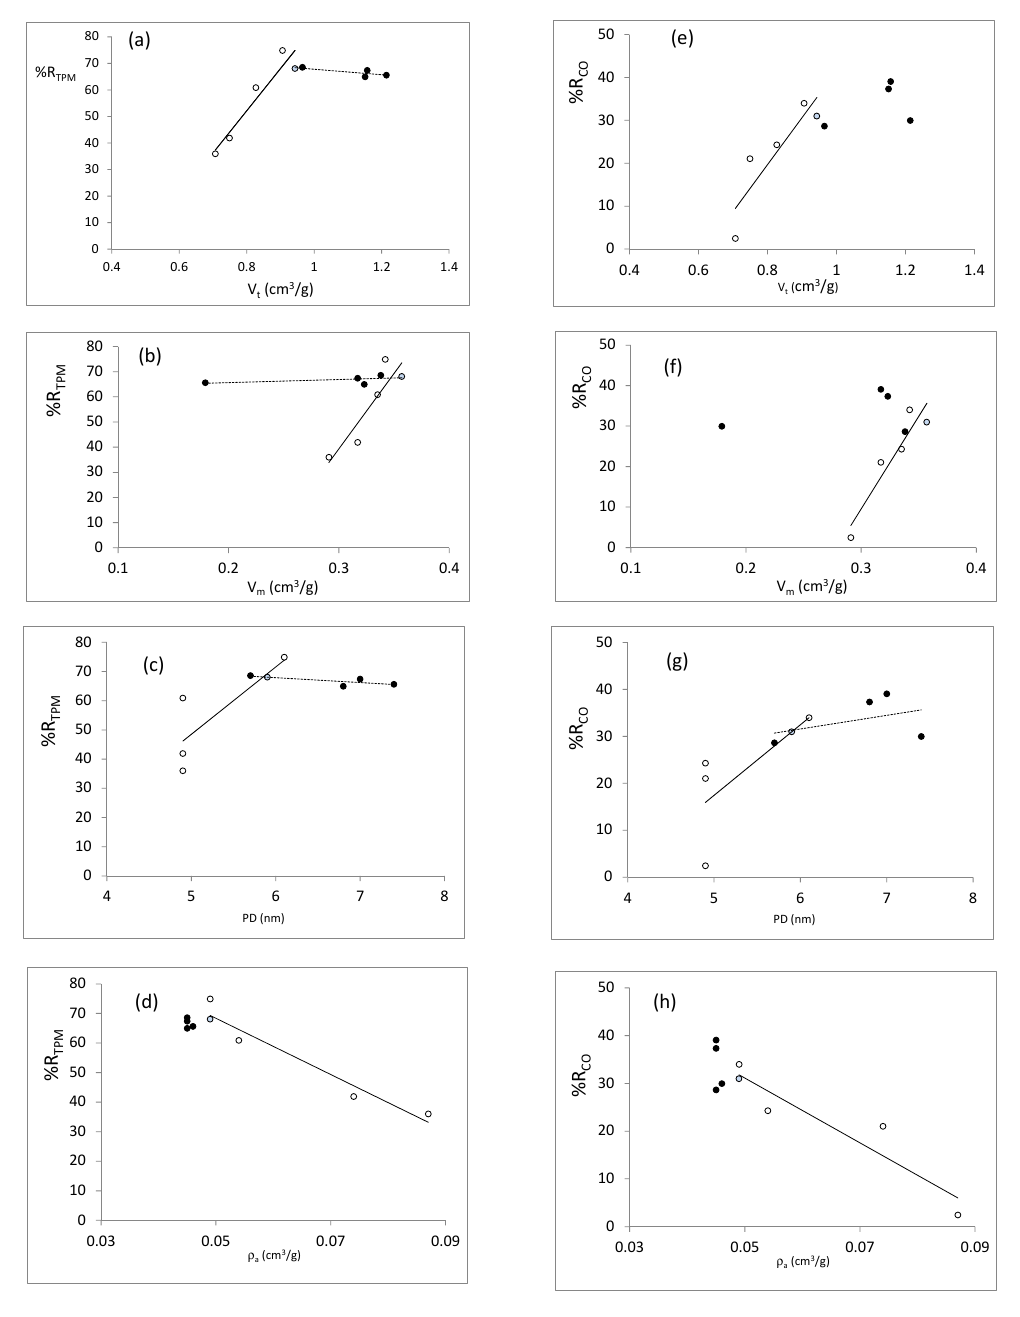
Figure 13. TPM reductions vs structural properties: ( a ) total pore volume, ( b ) mesoporous volume, ( c ) pore diameter and ( d ) relative density. CO reductions vs structural properties: ( e ) total pore volume, ( f ) mesoporous volume, ( g ) pore diameter, and ( h ) relative density. Black circles represent the series of temperature, white circles the series of time, and blue circle corresponds to the sample obtained at 24 h of thermal treatment at 80 °C.